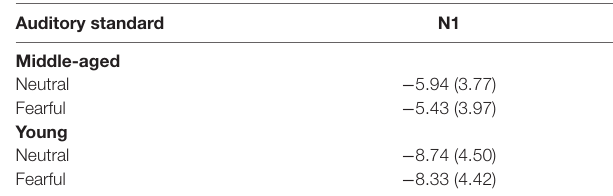
TABLE 1 | Mean amplitudes of N1 components (at Fz site) elicited by auditory standard stimuli for each emotion ( µ V with SD) in young and middle-aged